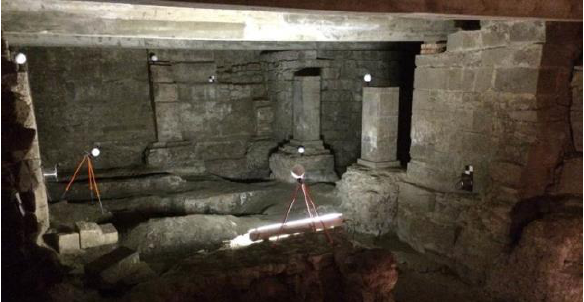
Figure 3. Network of spherical targets established in the basement of the Chapel.